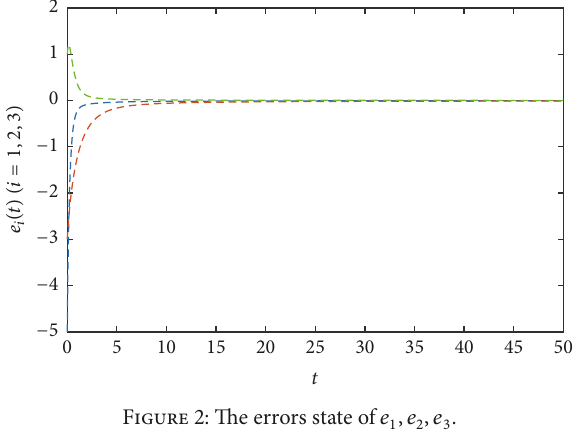
Figure 2: The errors state of 𝑒 1 ,𝑒 2 , 𝑒 3 .